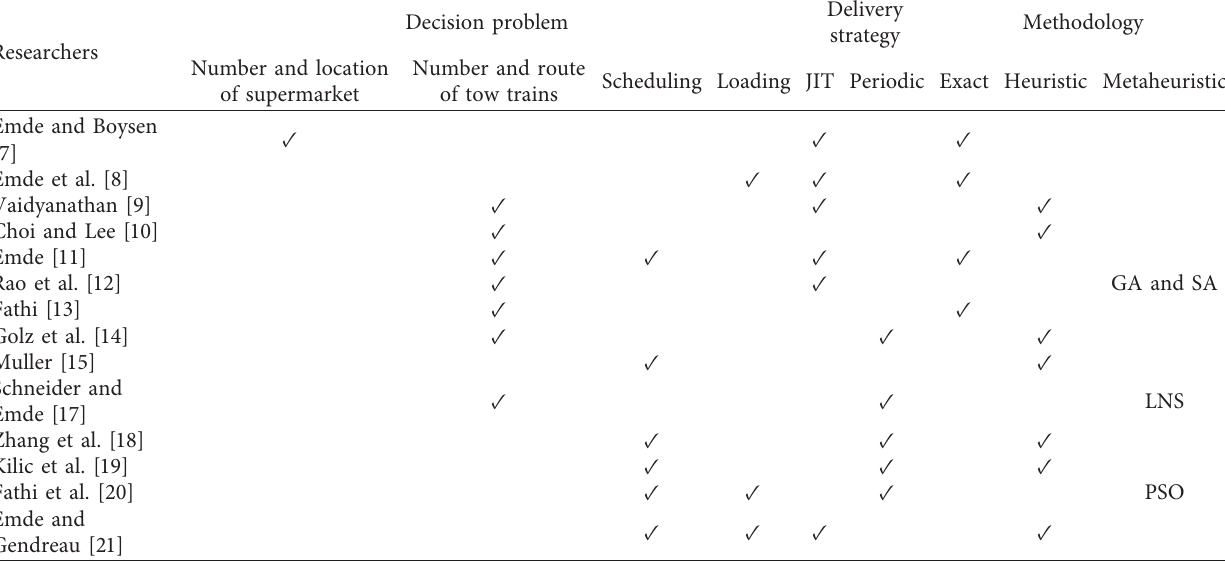
Table 1: Summary of related literature.